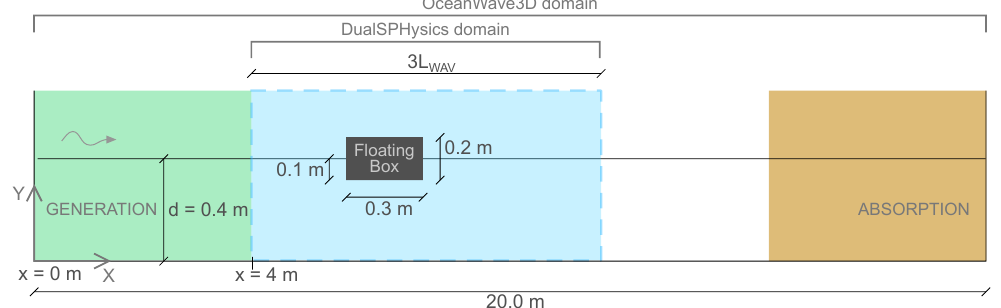
Figure 8. Numerical test set-up for simulation of the response of a floating box to a custom wave signal. The DualSPHysics domain and OceanWave3D domain are indicated. L wav is the wavelength.